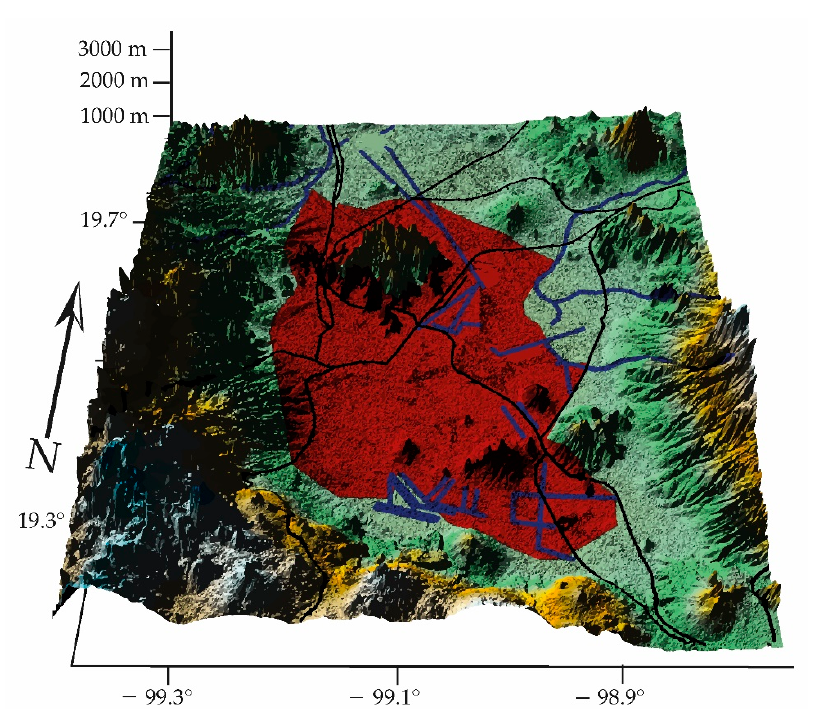
Figure 14. C K, México City = 0,35, the entropy of pollutants dominates the local micrometeorology (GCS, WGS84). (g) The Centro station is located within the commune of Calama, an inland and Andean city of Antofagasta (Figure 15):